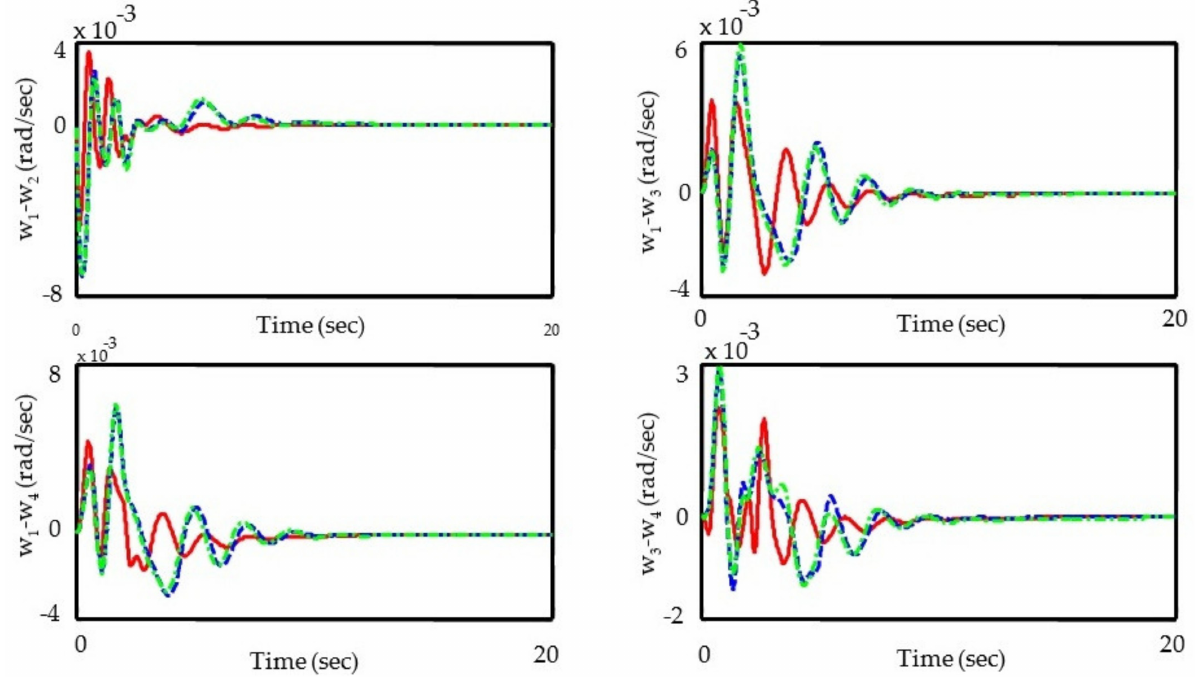
Figure 11. Angular velocity deviation for the second scenario for the rated load; proposed (red line), BFA (blue dashed line), GA (green dash–dotted